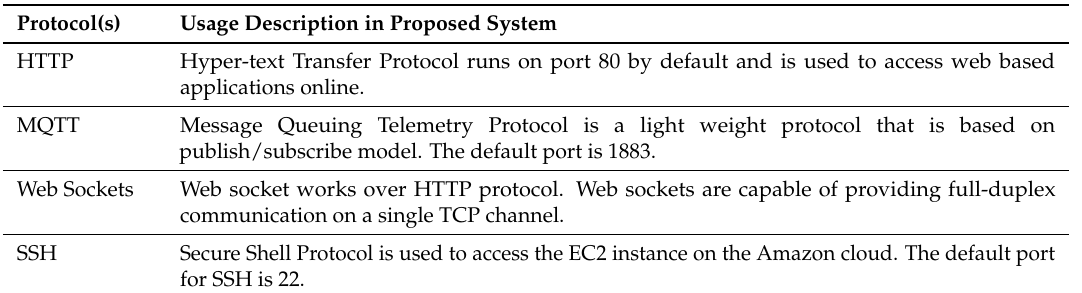
Table 2. Various protocols used for communication in the virtual IoT network.